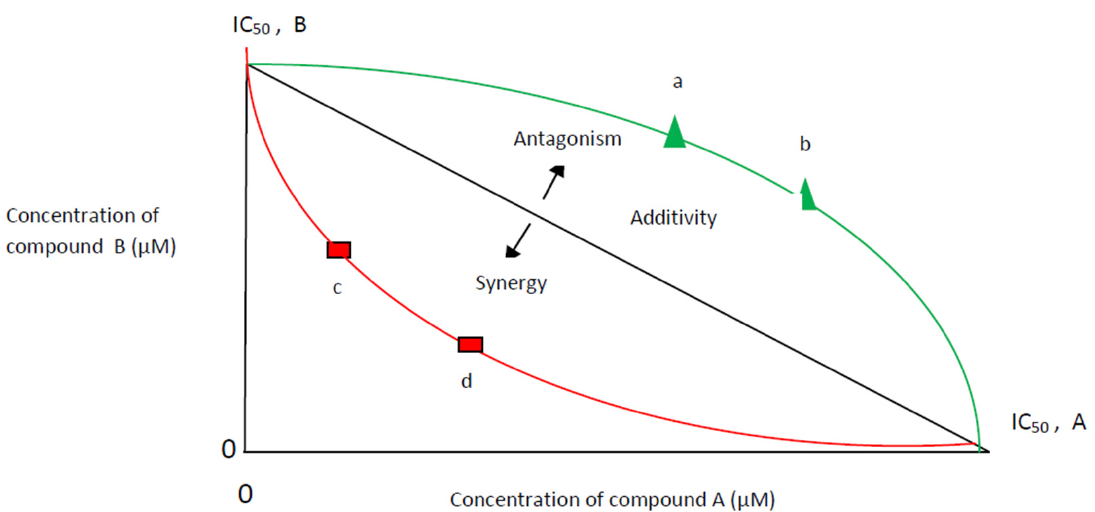
Figure 2. Isobologram model at half maximal inhibitory concentration (IC 50 ). Additivity: A line from IC 50 of compound A to IC 50 of compound B ; Synergy: any combination points (c,d) lower of additivity line-concave curve; Antagonism: any combination points (a,b) upper of additivity line-convex curve.